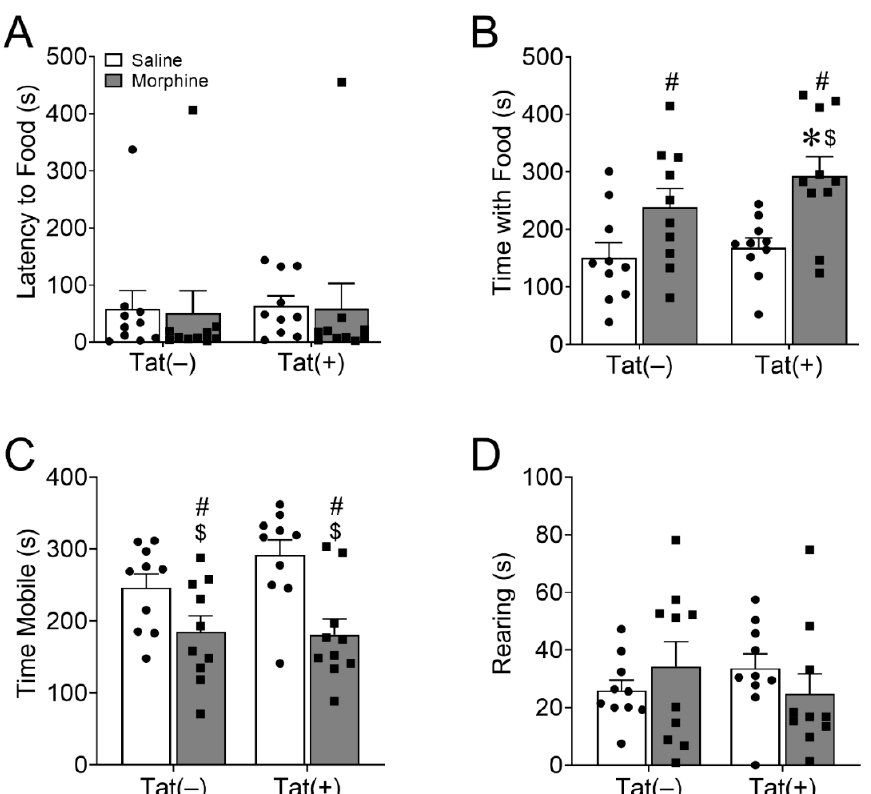
Figure 4. Morphine, but not HIV-1 Tat, increased feeding in a novel environment after food deprivation. The main effects indicated that ramping morphine (10–40 mg/kg, increasing by 10 mg/kg/2 day, s.c., b.i.d.), regardless of genotype, increased doxycycline pellet feeding time in a novel environment after overnight food deprivation ( B ) with no difference in latency ( A ). Planned comparisons revealed that Tat(+) morphine-exposed mice spent more time feeding than Tat(–) or Tat(+) and saline co-exposed mice ( B ). Morphine-treated mice also spent less time mobile in the novelty-suppressed feeding test ( C ), but there was no effect of morphine or Tat on rearing behavior ( D ). Data are presented as the mean ± the SEM; n = 10 mice per group; $ p < 0.05 interaction vs. Tat(+) Saline; * p < 0.05 interaction vs. Tat(–) Saline; # p < 0.05 main effect of morphine.